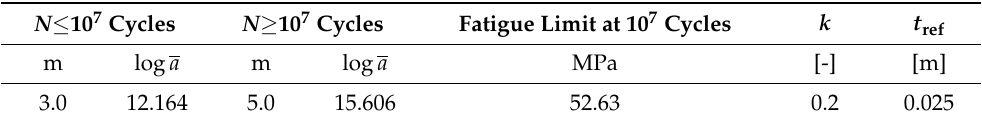
Table 4. S-N curve parameters of the